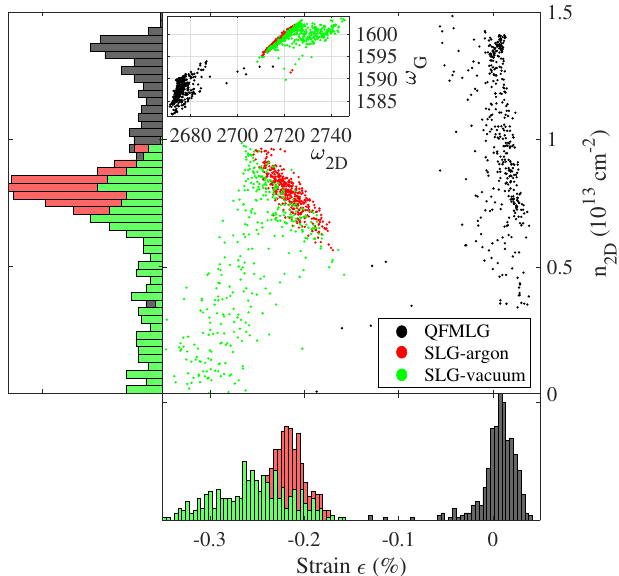
Figure 7. The variation of the charge density and strain as determined from the spectral position of the G and 2D peaks in the three samples (QFMLG, SLG-Ar, SLG-vac). The inset shows the correlation between the G and 2D peak positions. The left and bottom histograms depict the distribution of the charge density and strain,